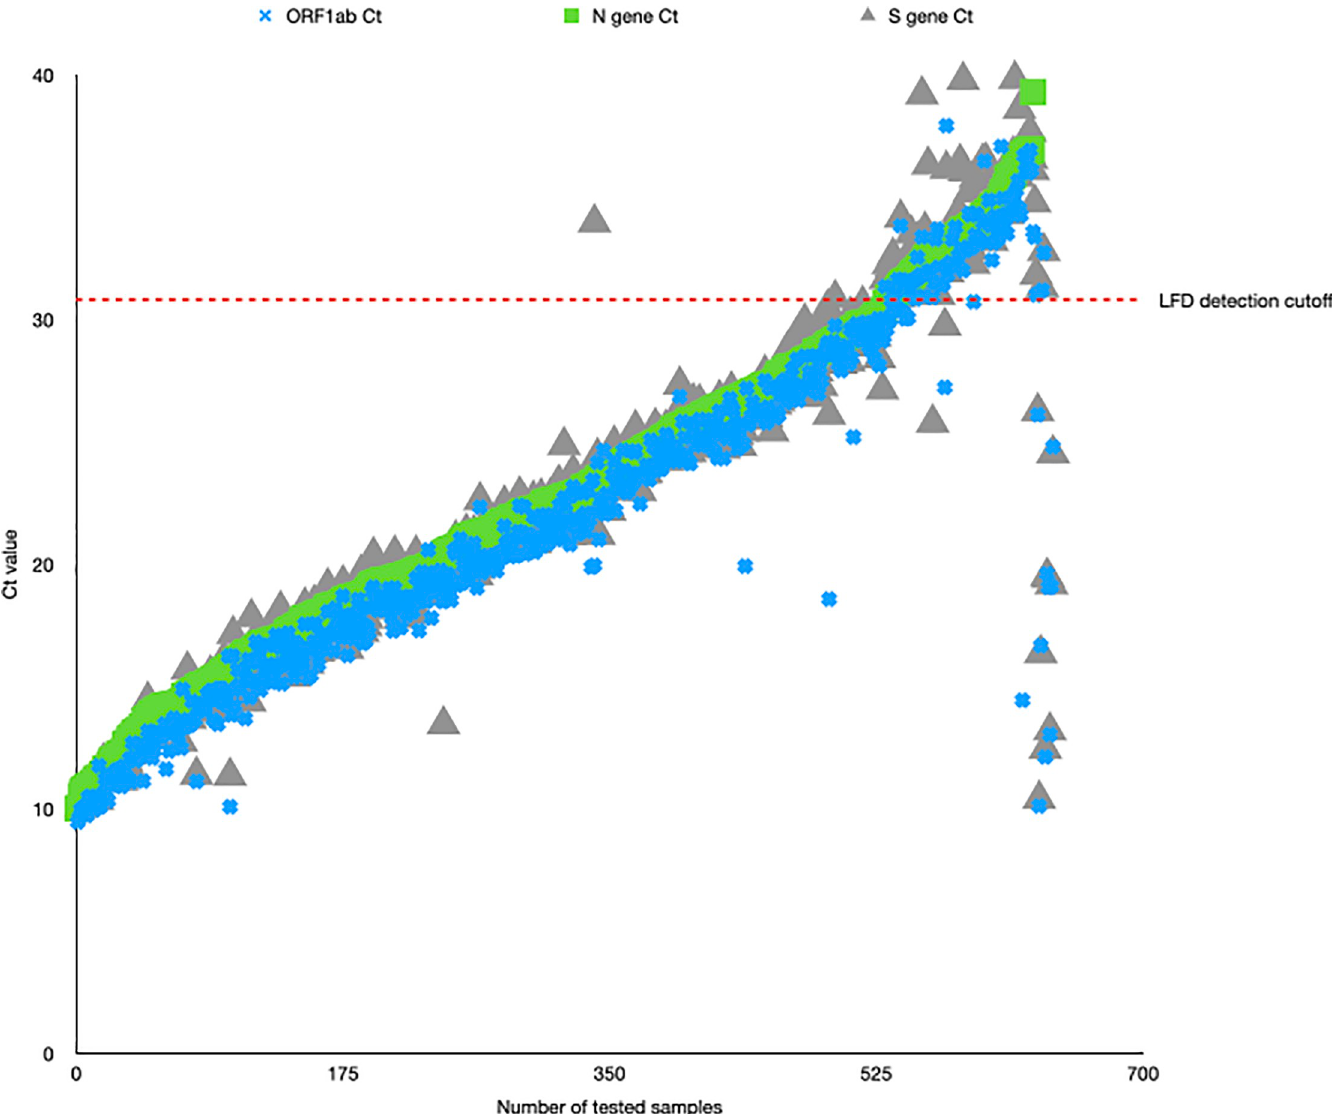
Fig 2. Graph plotting raw Ct values (y-axis) for all 641 positive samples in the Birmingham Turnkey lab (y-axis). Ct values for each of the targets (Orf1, N, S) are plotted, with a sample only called positive if at least 2 of the 3 targets have a Ct < 35. The red line indicates the N gene Ct value equating to 100 viral copies/ml, the previously determined LoD for the Innova LFD. Ct, cycle threshold; LFD, Lateral Flow Device; LoD, Limit of